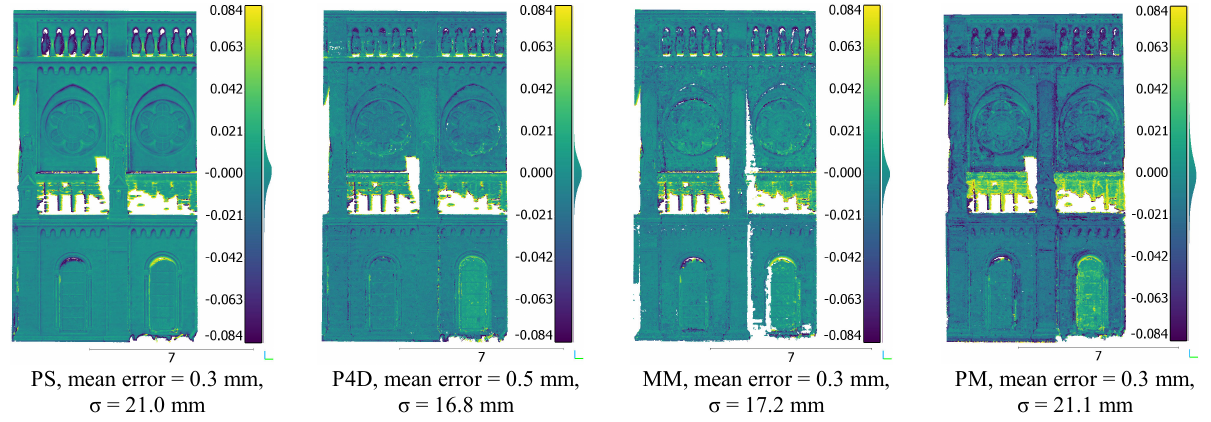
Figure 7. Comparison of dense matching results of the South-Eastern portal to TLS data.